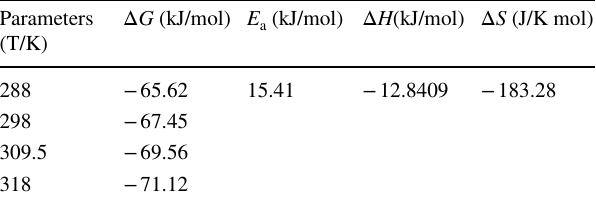
Fig. 7 Arrhenius plot and thermodynamic function for the adsorption of BSA on diatomite clay Table 5 Thermodynamic function data obtained by adsorption